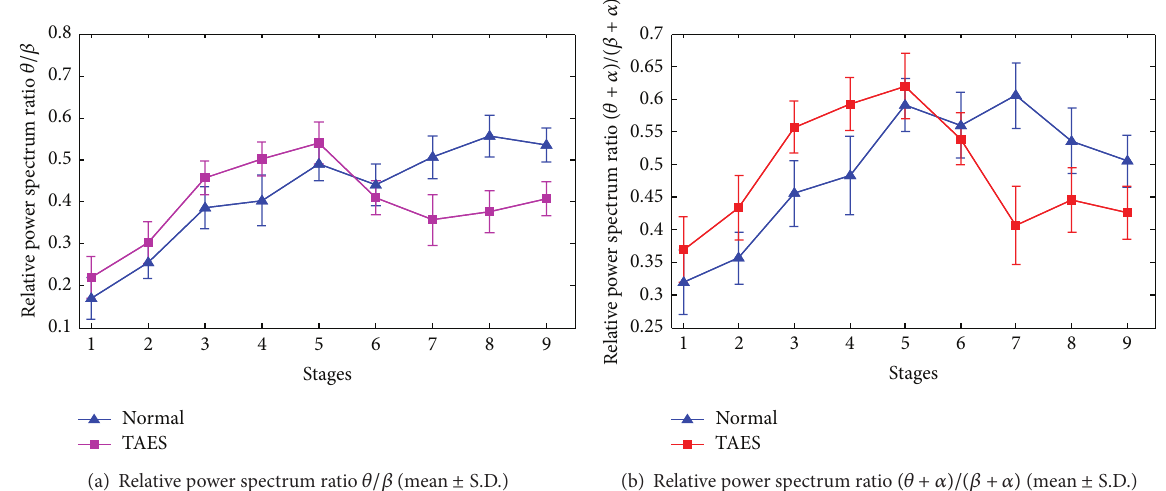
Figure 7: Ratios 𝜃/𝛽 and (𝜃 + 𝛼)/(𝛽 + 𝛼) of the relative power spectrum for 9 stages of driving.